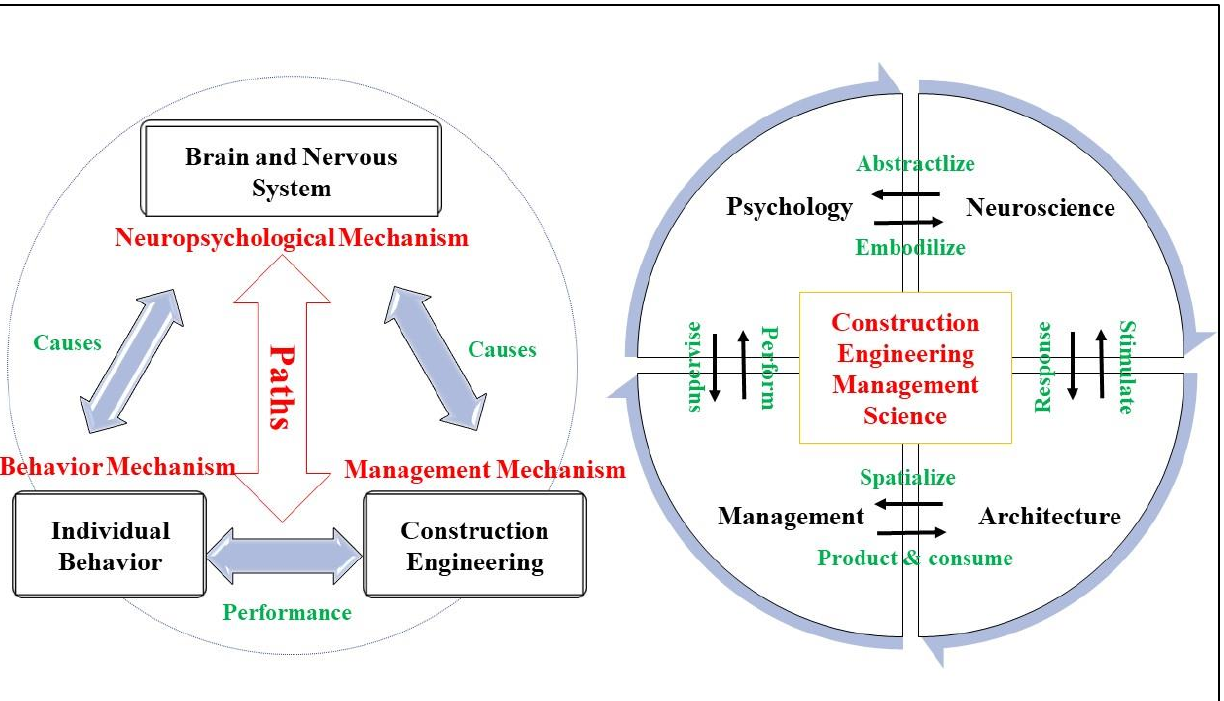
Figure 7. Interdisciplinary interrelationship.